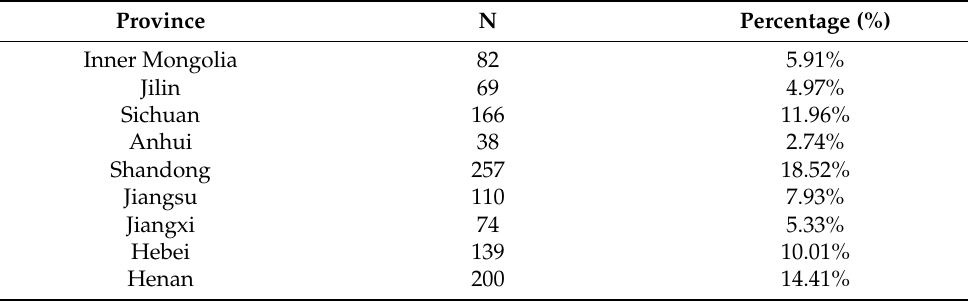
Table 1. Distribution of observations by province/autonomous